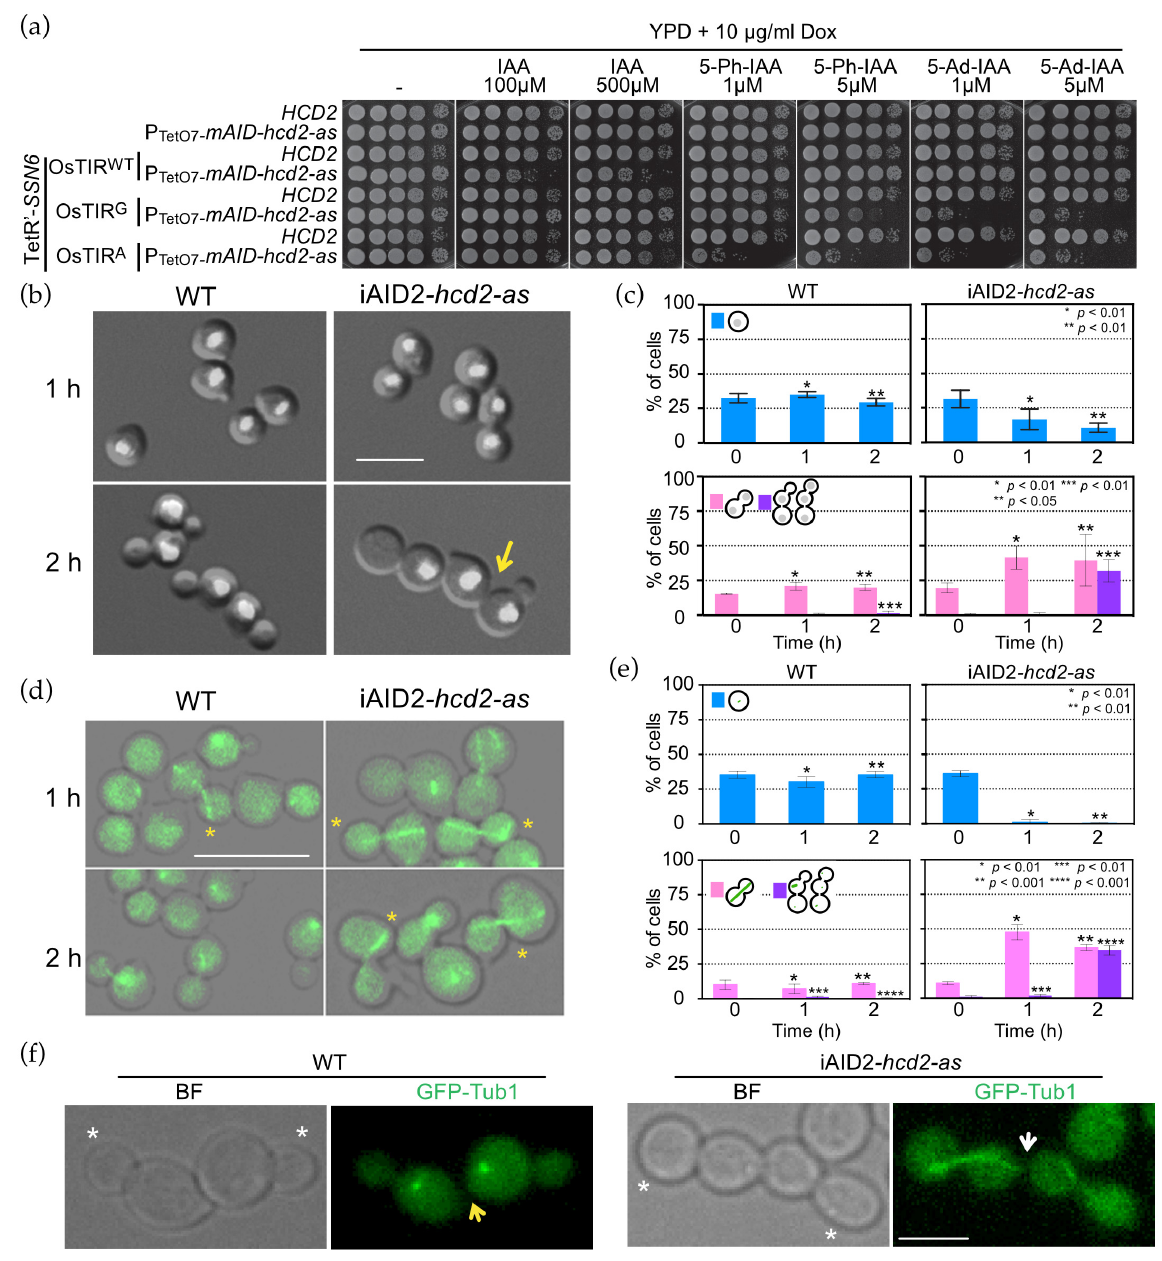
Figure 3. OpHcd2 depleted cells are defective in mitotic exit and cytokinesis. ( a ) Serial dilutions of strains with the indicated genotype were spotted on YPDS agar plates containing IAA, 5-Ph-IAA, or 5-Ad-IAA at the indicated concentrations and incubated at 30 °C for 1 day. Yeast strains: HPH656, HPH2067, HPH2254, HPH2246, HPH2270, HPH2244, HPH2245, HPH2247. ( b ) DAPI staining of iAID Op -hcd2-as strains. Wild type (HPH2247) and iAID Op -hcd2-as cells (HPH2245) carrying P ADH1 - OsTIR F74A , P CMV -tTA, P OpTEF1 - TetR’-OpSSN6-5flag were grown in YPDS medium until logarithmic growth phase. Dox was added at 5 µg/mL to repress the expression of the mAID-hcd2-as gene, IAA at 0.5 mM to induce the mAID-OpHcd2-as protein degradation, and 1NM-PP1 at 5 µM to inhibit the activity of any residual iAID Op -Hcd2-as that escaped degradation, and incubated at 30 °C for up to 2 h. Cells were fixed with 70% ethanol and DNA was stained with DAPI. Shown are merged